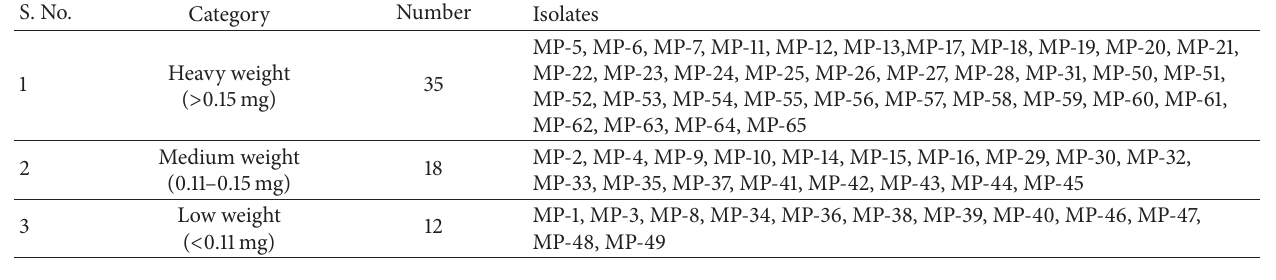
Table 5: Categorization of M. phaseolina isolates on the basis of weight of sclerotia S. No.